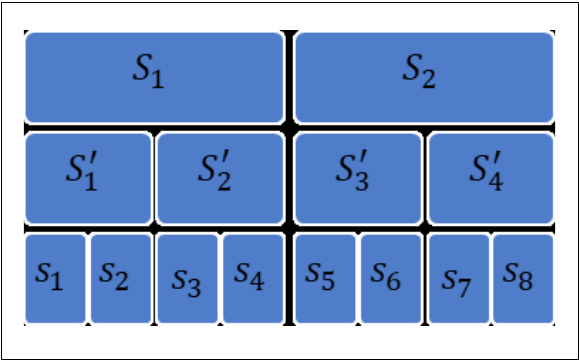
Example for notational purposes: Wong’s